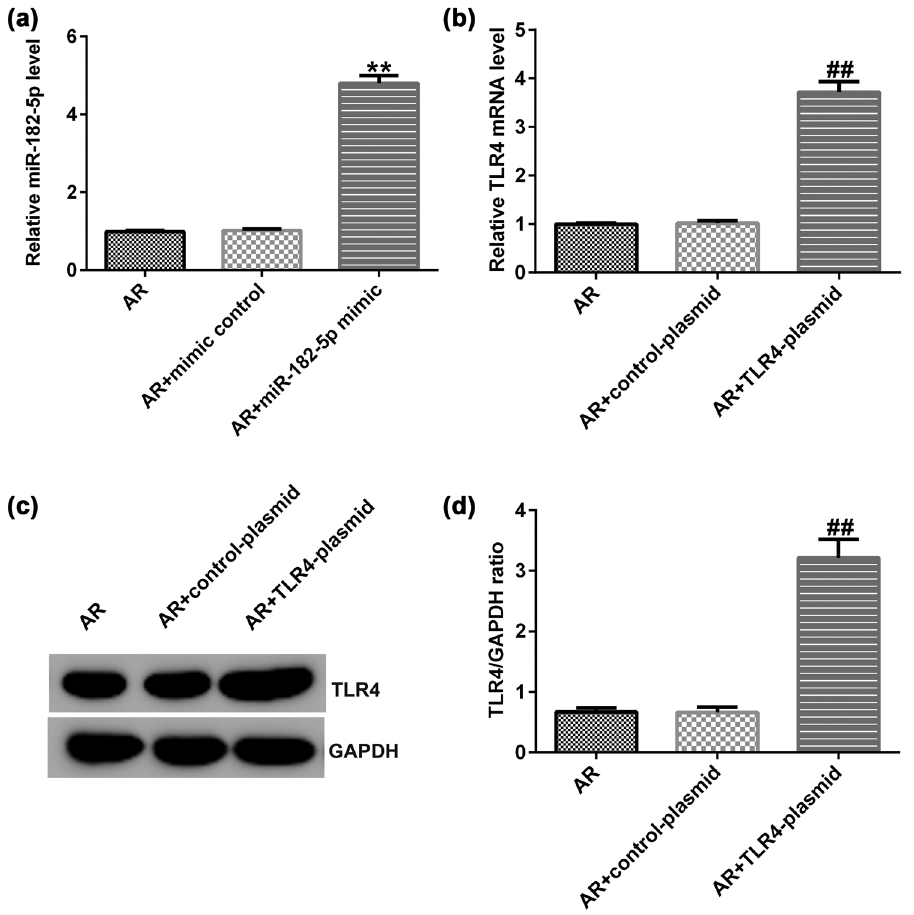
Figure 3: miR - 182 - 5p mimic and TLR4 plasmid increase miR - 182 - 5p and TLR4 expression in AR mice. ( a ) qRT - PCR analysis was used to detect miR - 182 - 5p expression in the AR group; AR + mimic control group and AR + miR - 182 - 5p mimic group ( n = 3 ) . ( b ) qRT - PCR analysis was used to detect TLR4 expression in the AR group; AR + control - plasmid group and AR + TLR4 plasmid group ( n = 3 ) . ( c ) Western blot analysis for the detection of TLR4 protein levels. ( d ) TLR4/GAPDH ratio was calculated and presented. TLR4, toll - like receptor 4; qRT - PCR, quantitative reverse transcription - PCR; AR, allergic